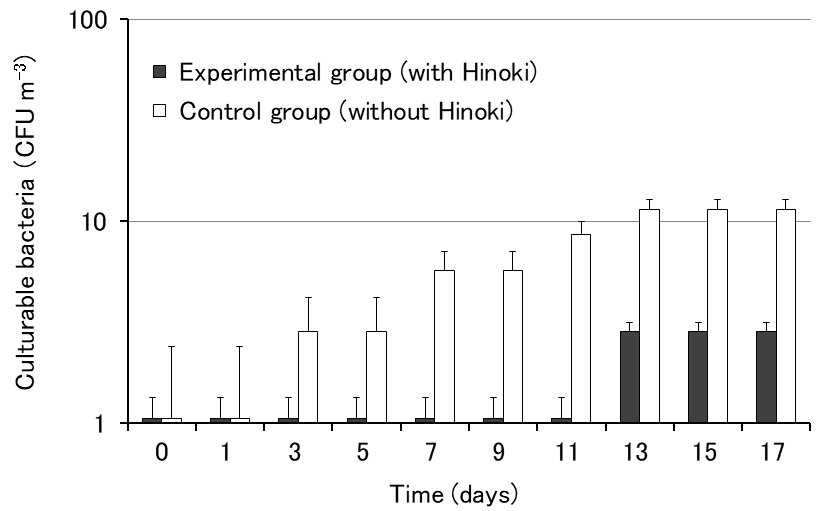
Figure 2. Growth of airborne bacteria on nutrient agar with and without Hinoki. Each bar represents the mean of five agar plates. The error bars indicate standard errors.